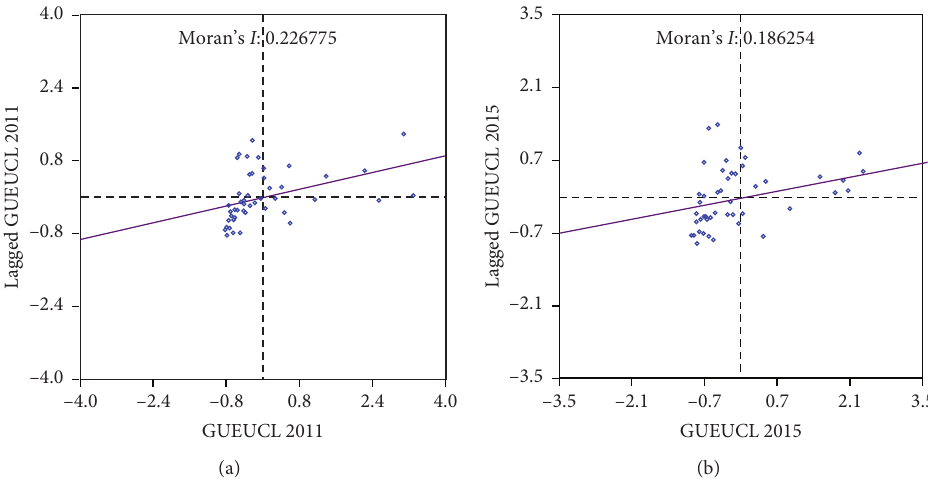
Figure 4: Moran scatter plot of green utilization efficiency of urban construction land at different time